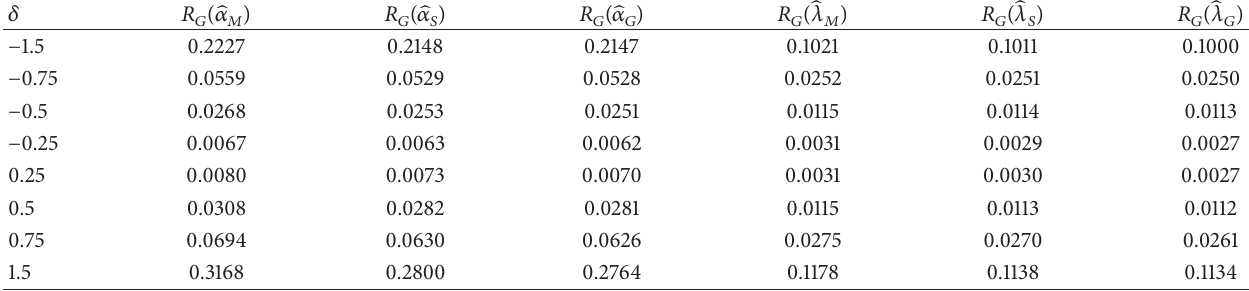
Table 2: Risks of estimators of 𝛼 and 𝜆 under GELF for fixed value of 𝑛 = 15 , 𝑚 = 9 , 𝑝 = 0.5 , 𝑎 1 = 0.00001 , 𝑏 1 = 0.0001 , 𝑎 2 = 0.00001 , and 𝑏